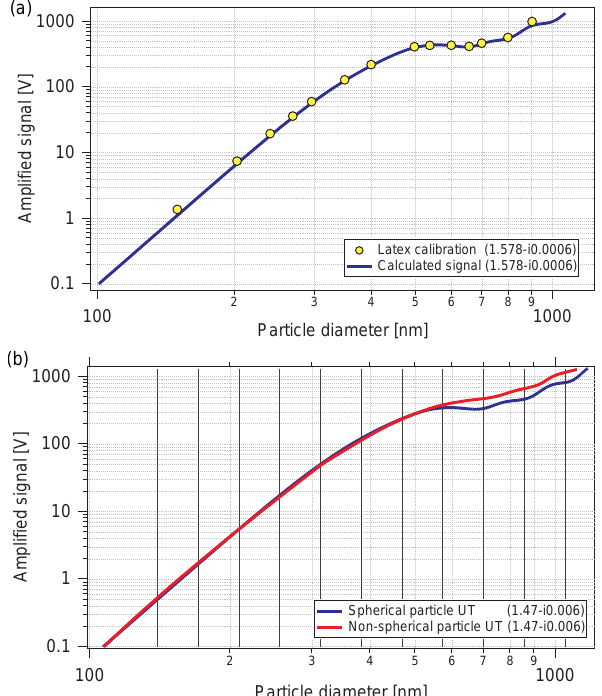
Figure 8. Response function of the CARIBIC OPSS for perpen- dicular polarized light: (a) PSL calibration measurement data and calculated PSL response function; (b) calculated response functions for spherical and slightly nonspherical UT particles. Solid vertical lines indicate the finally chosen particle size bin borders.